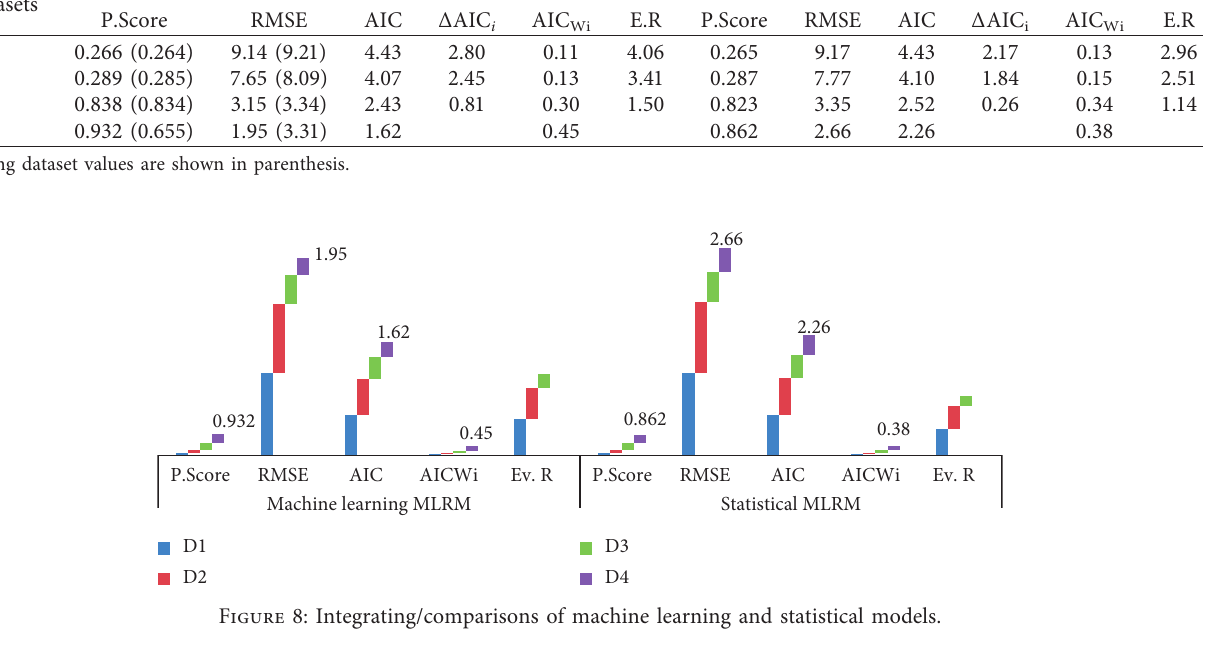
Table 2: Integrating machine learning and tradition statistics modeling for MLR.